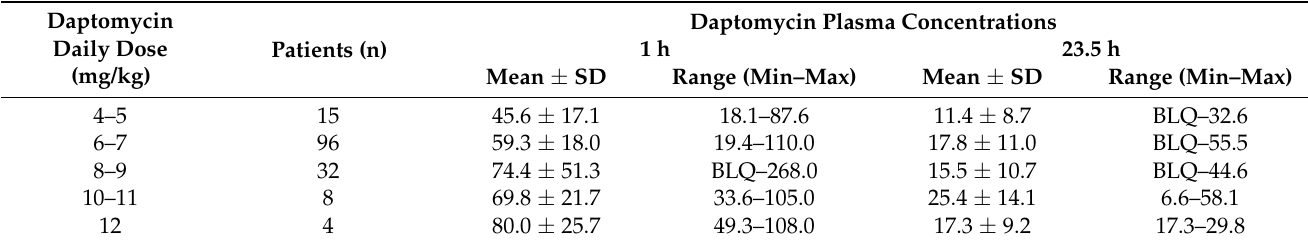
Table 2. Values (mean ± SD, minimum–maximum range) of 424 daptomycin plasma concentrations measured in the present study.